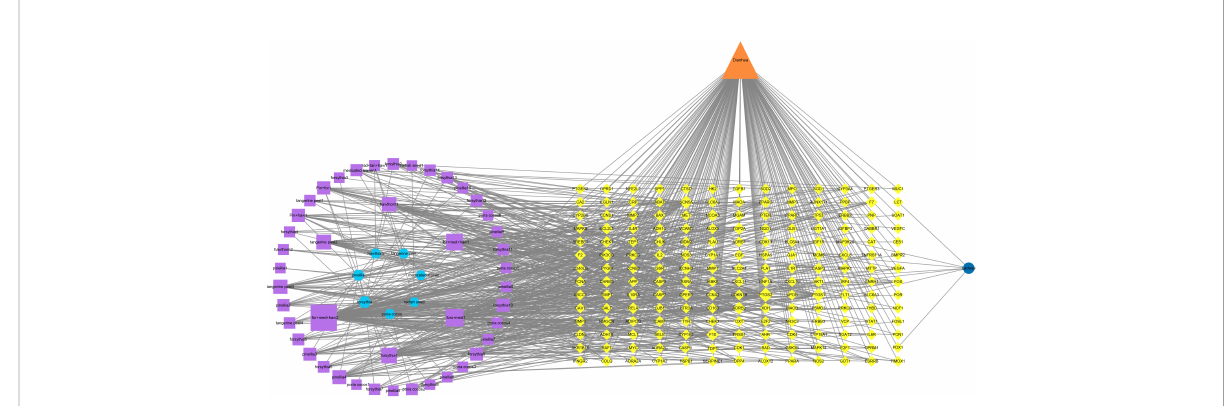
FIGURE 3 Baohe pill-active ingredient-lactase-diarrhea correlation network. The light blue hexagon is the 7 herbs composed of Baohe pill, the purple square is the active ingredient, the yellow diamond is the potential target, the orange triangle is diarrhea, and the dark blue circle is lactase. The connection line between the nodes represents the corresponding relationship between the two.